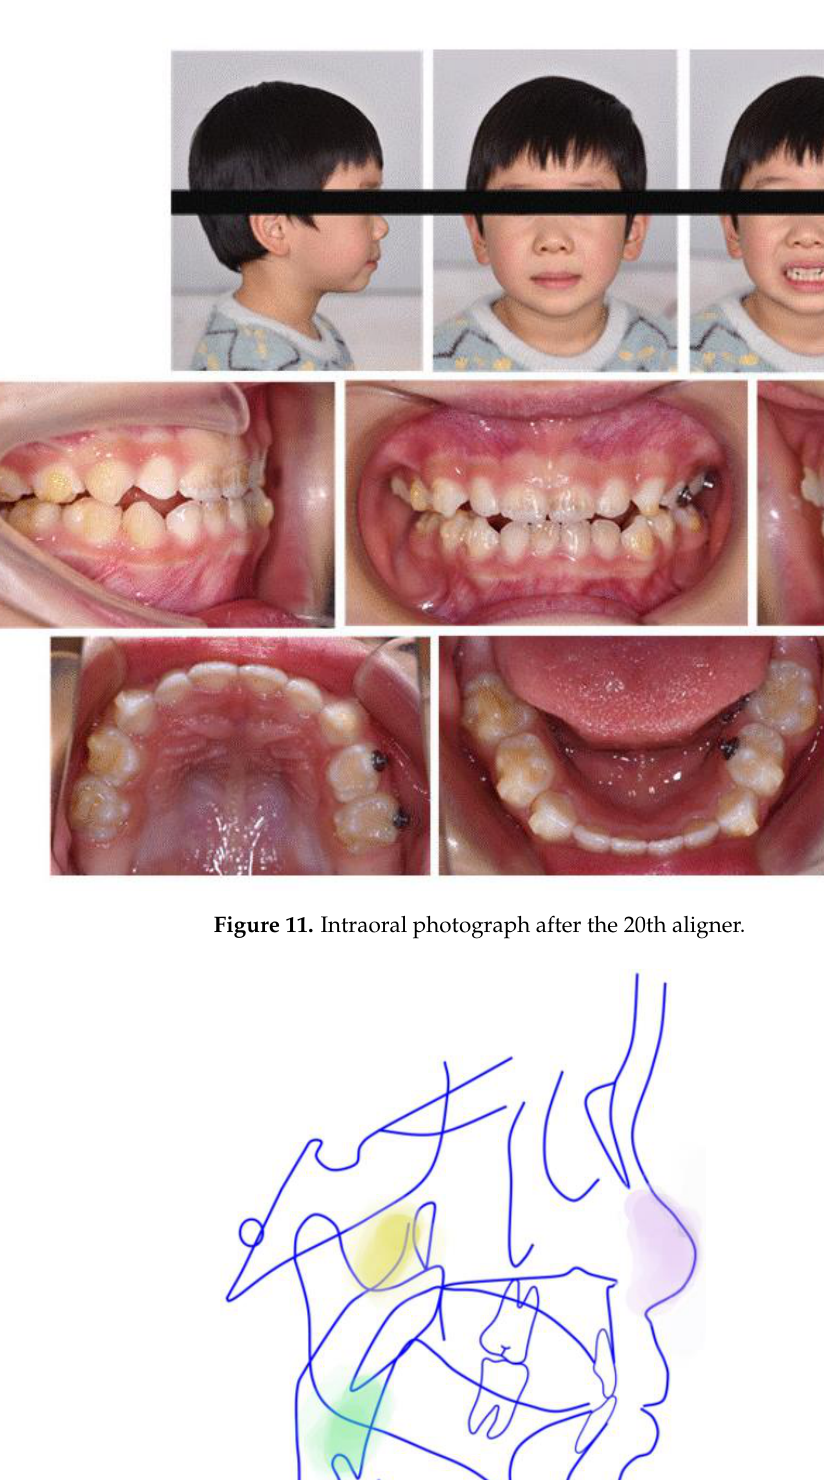
Figure 10. Intraoral photograph after the 8th aligner.